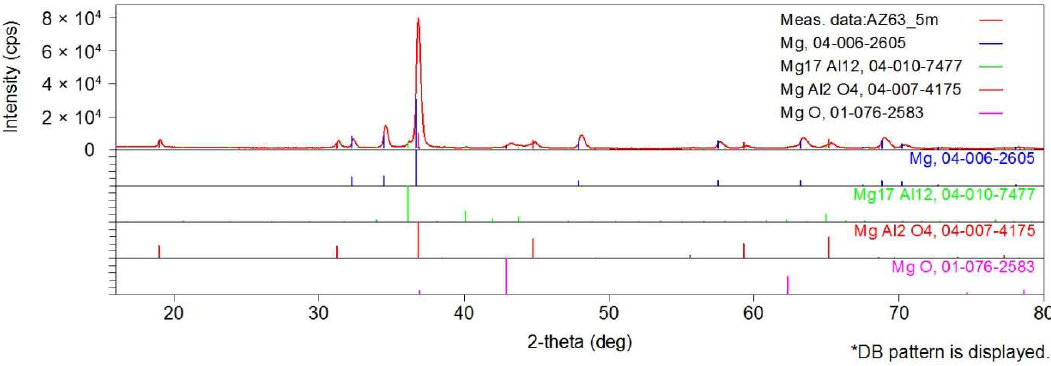
Figure A2. AZ63_5m sample—XRD qualitative phase analysis with displayed PDF cards peak bars.